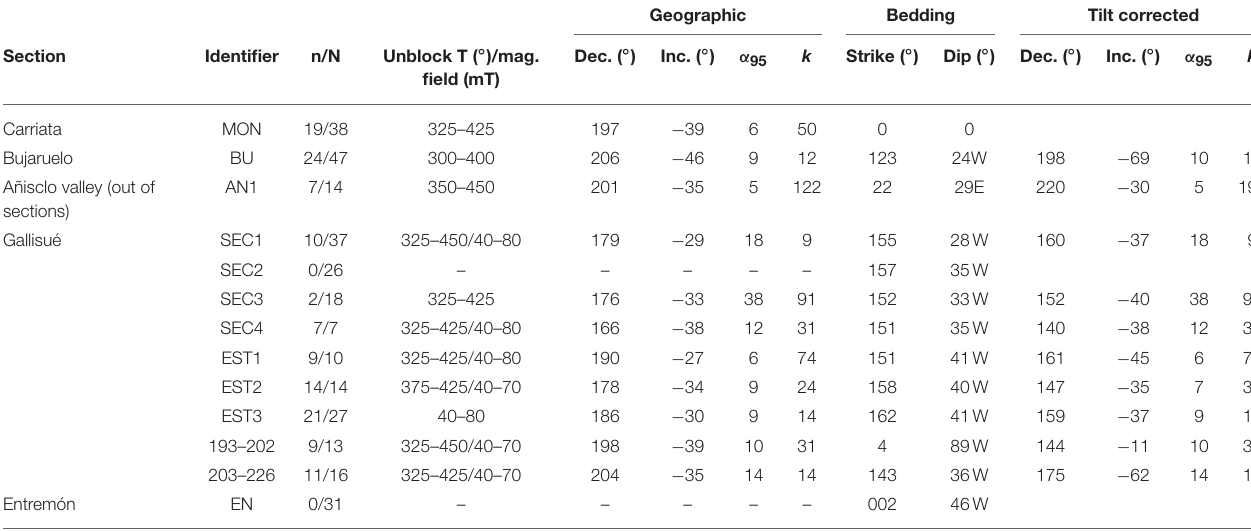
TABLE 1 | Averages for the paleomagnetic component calculated in each section.